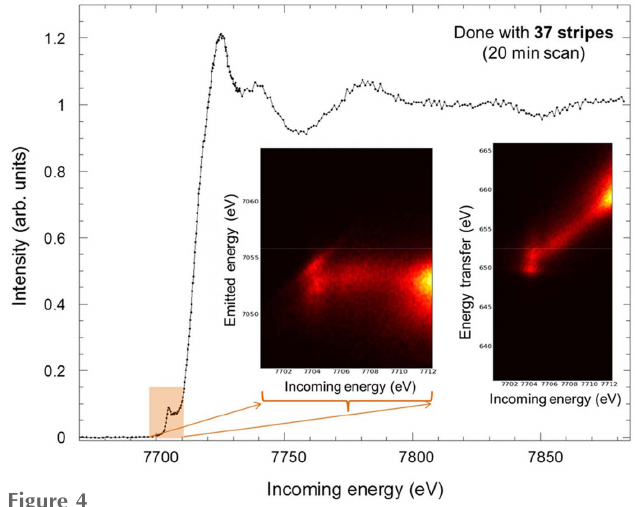
Figure 4 High-resolution Co K -edge X-ray absorption spectra, where the insets report bidimensional plots representing the spectral intensity as a function of the emitted (or transferred) and incoming photon energy in the pre-peak absorption region.